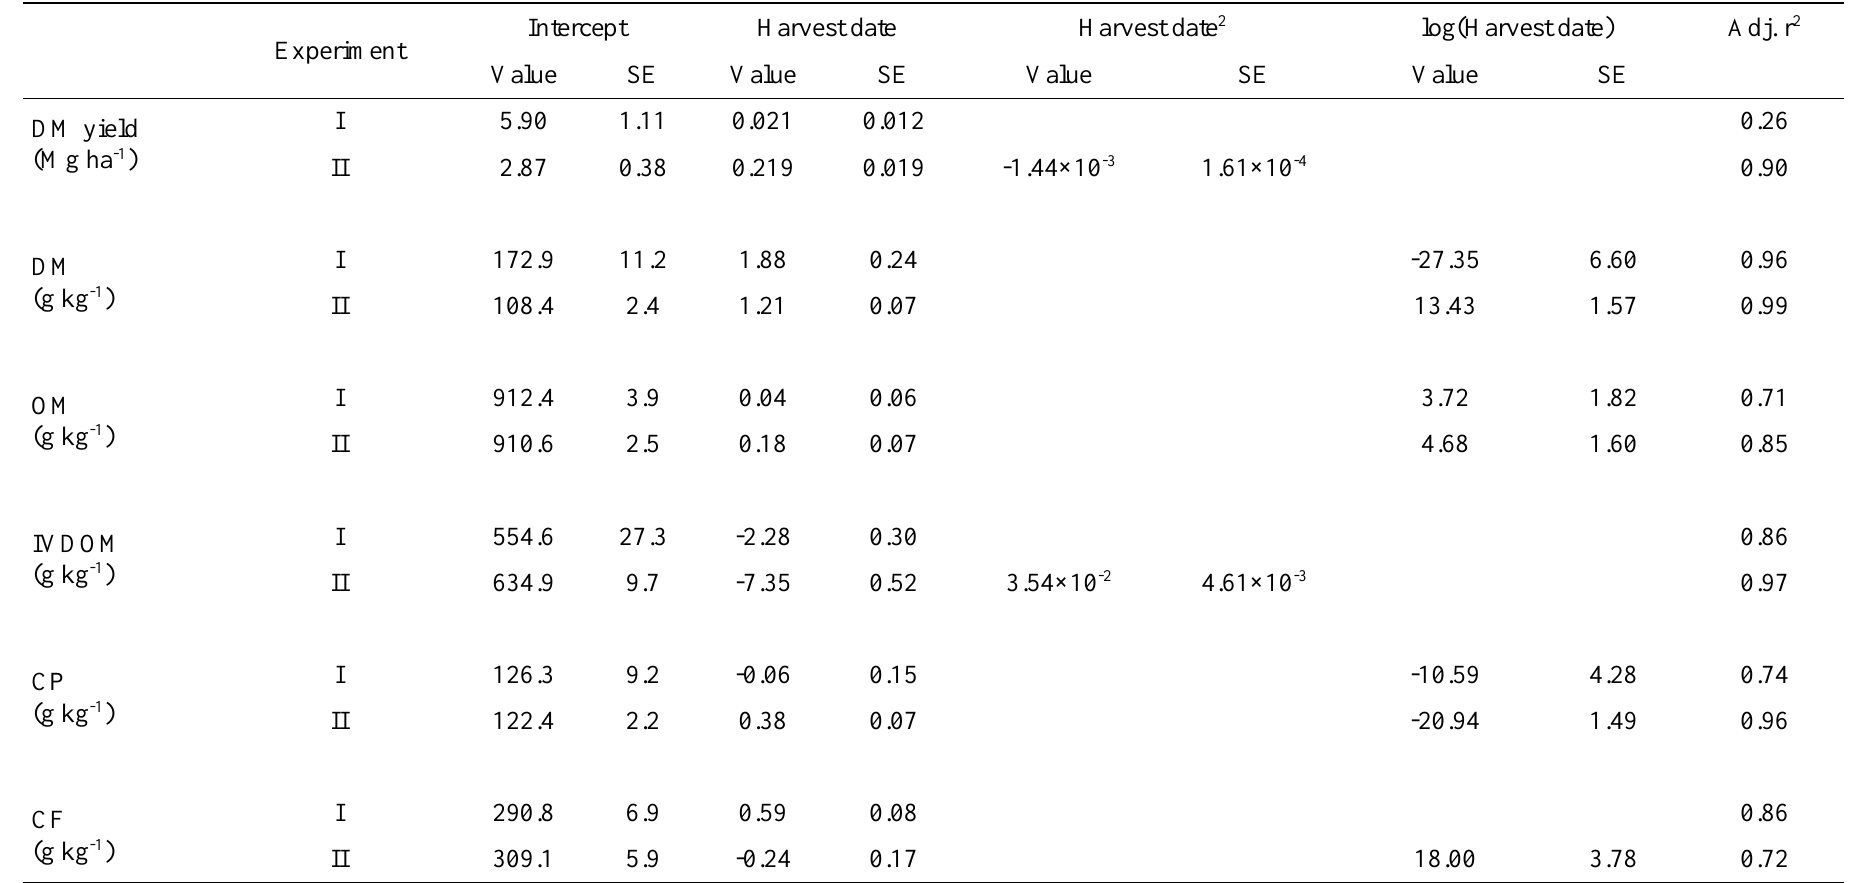
Table 2. Experiments I and II: Effect of harvest day on dry matter (DM) yield and DM, and on the dry matter contents of organic matter (OM), in vitro digestible organic matter (IVDOM), crude protein (CP) and crude fibre (CF) in T. latifolia biomass one year after planting. Fitted parameters to the (maximum) function y = intercept + harvest date + harvest date 2 + log(harvest date) + error , in which y represents DM yield or biomass content variables and harvest date the number